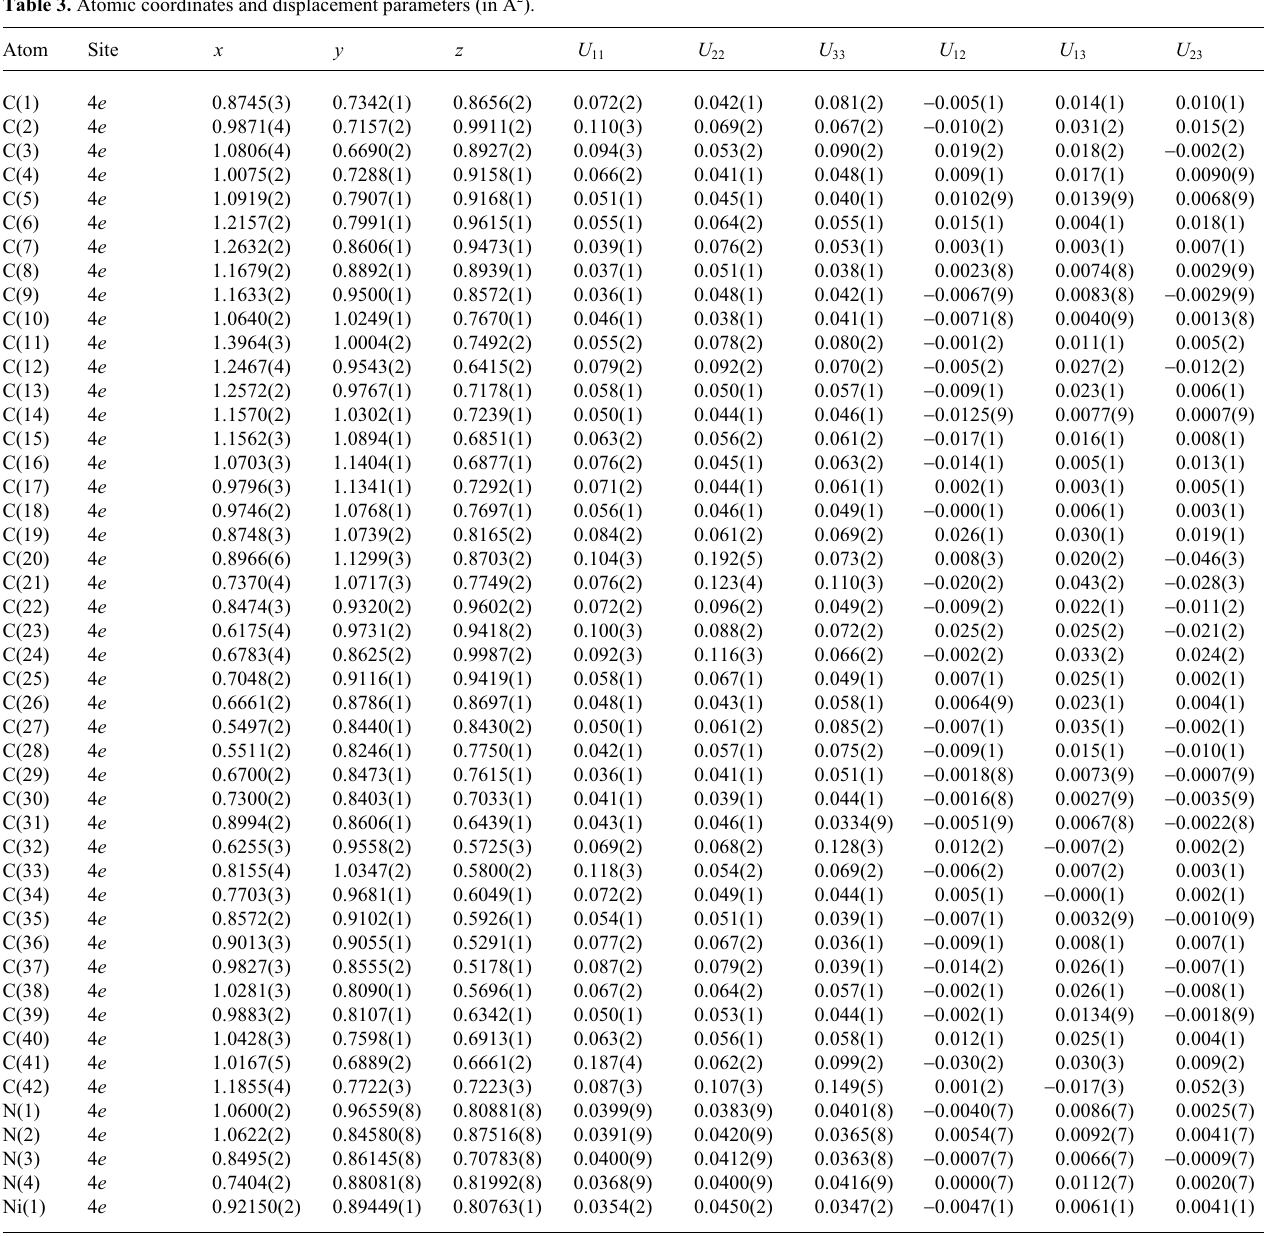
Table 3. Atomic coordinates and displacement parameters (in Å 2